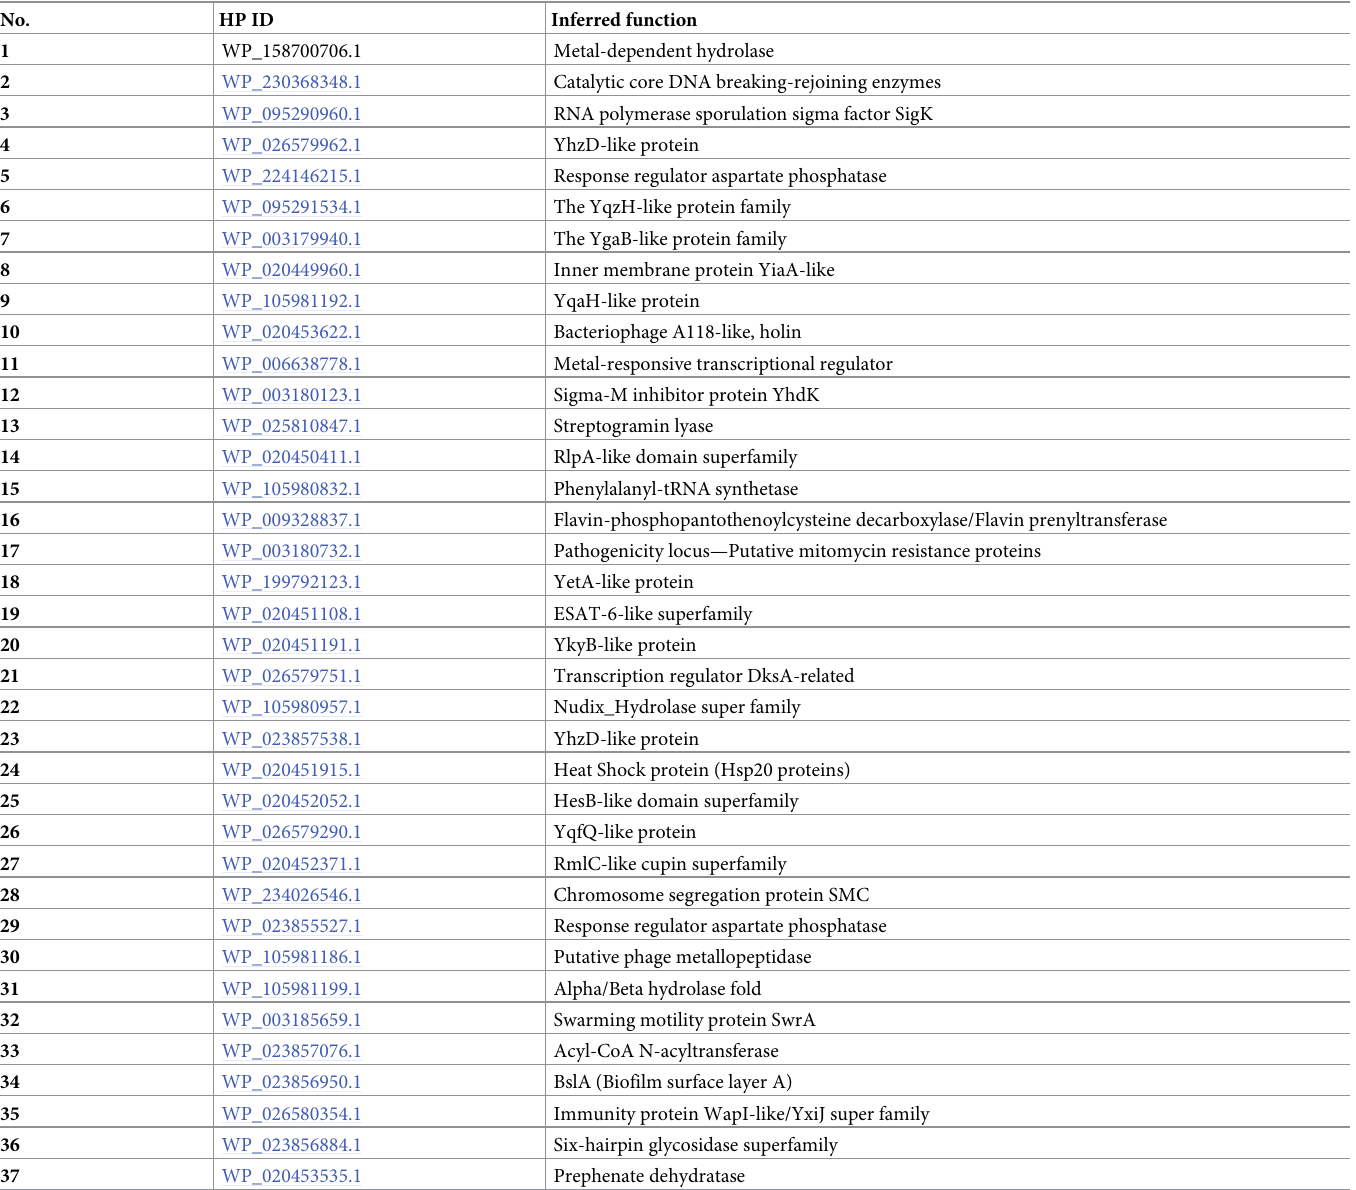
Table 1. Hypothetical proteins functionally annotated from the B . paralicheniformis strain Bac84.